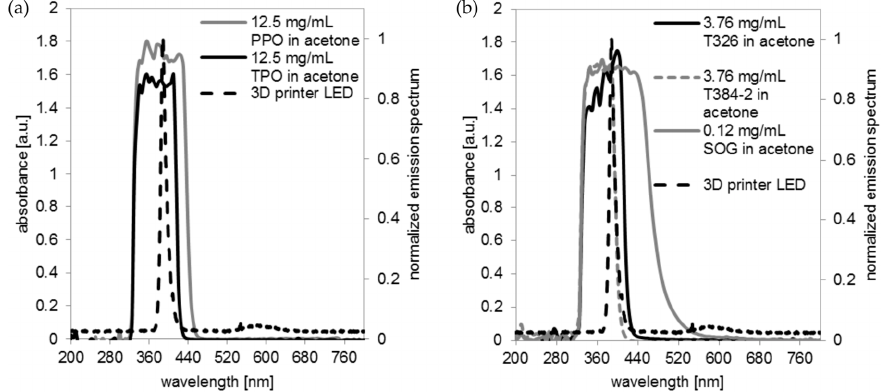
Figure 1. Absorption spectra of initiators and absorbers tested in comparison to the spectrum emitted by the UV LED of the Asiga Pico 2 printer (three-dimensional (3D) printer LED): ( a ) Absorption spectrum of the initiators phenylbis(2,4,6-trimethylbenzoyl)phosphine oxide (PPO) and Diphenyl(2,4,6-trimethylbenzoyl)phosphine oxide (TPO). TPO (325–415 nm) shows a less broad absorption spectrum than PPO (325–465 nm); ( b ) Absorption spectra of the absorbers tested: Tinuvin 326 (T326), Tinuvin 384-2 (T384-2), and Sudan Orange G (SOG).